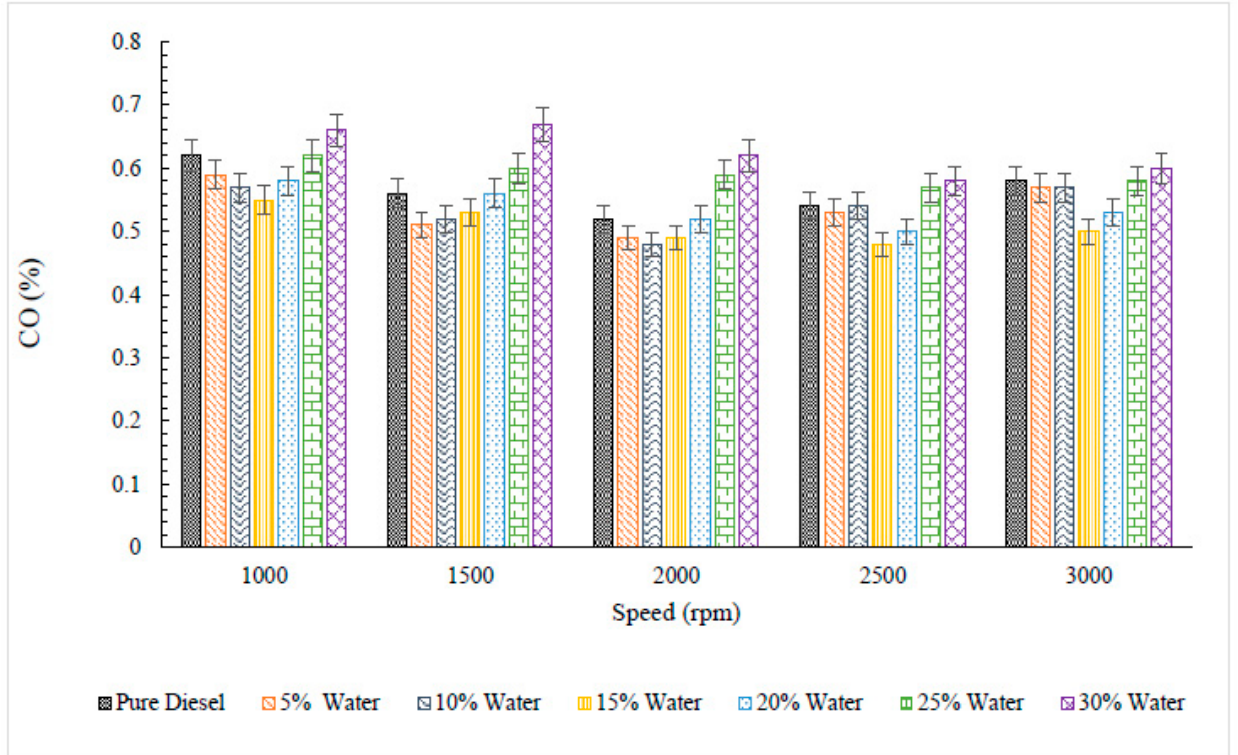
Figure 4. Effect of water-in-diesel emulsion fuel on carbon monoxide emitted from a diesel engine at different engine speed.